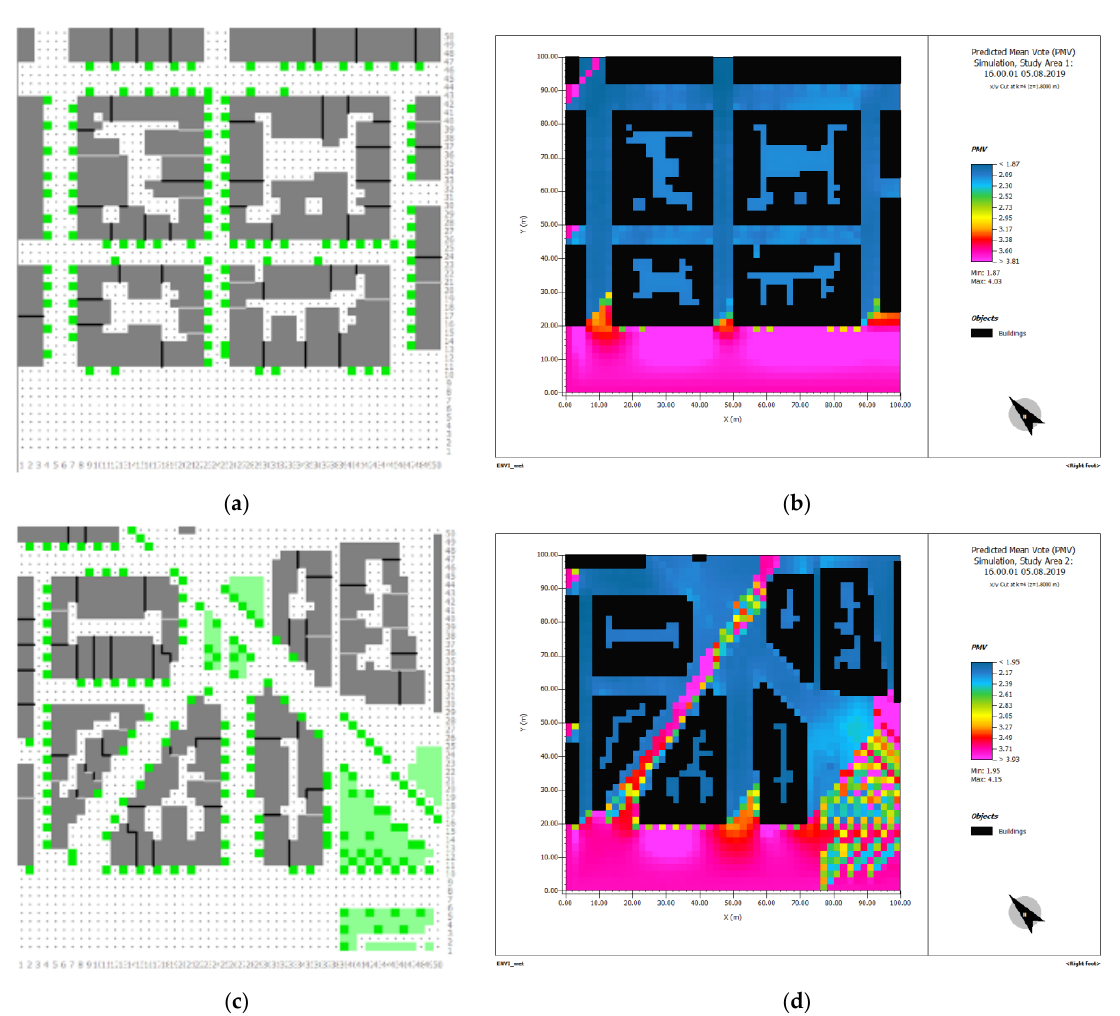
Figure 12 . ( a ) Two-dimensional display of the first section where the buildings are shown in gray and the positions of the tree planting in green; ( b ) PMV simulation for the first section; ( c ) Two-dimensional display of the second section where the buildings are shown in gray and the positions of the tree planting in green; ( d ) PMV simulation for the second section, ENVI-met© software.